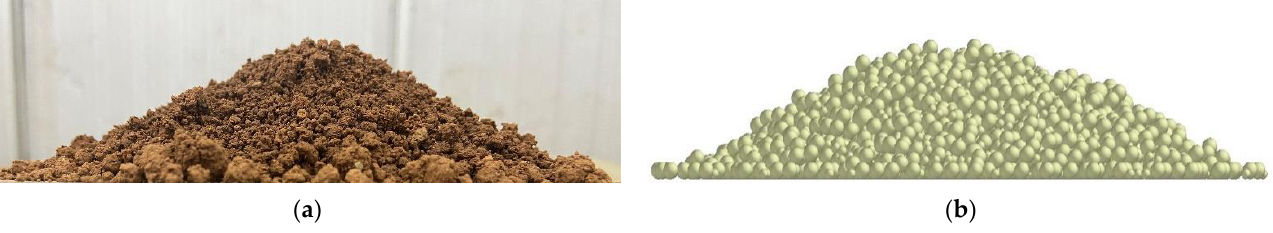
Figure 6. Comparisons between simulation and physical test for the soil stacking angle. ( a ) Physical